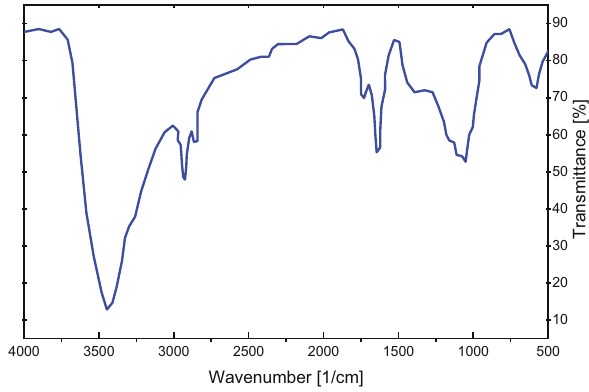
Figure 1: FTIR spectra of the synthesized GO.